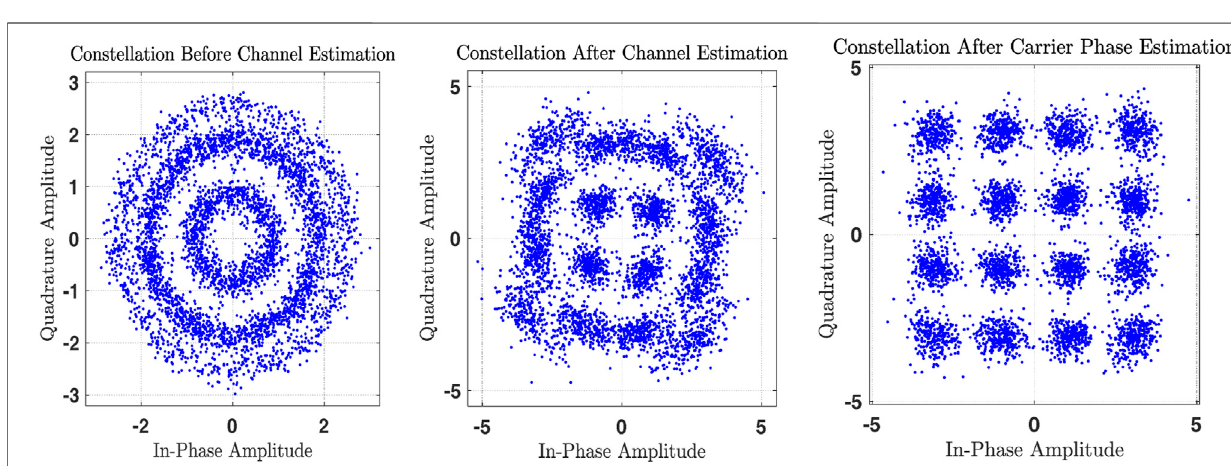
FIGURE 9 | 16-QAM constellation at 115 km SSMF for 100 Gbps data